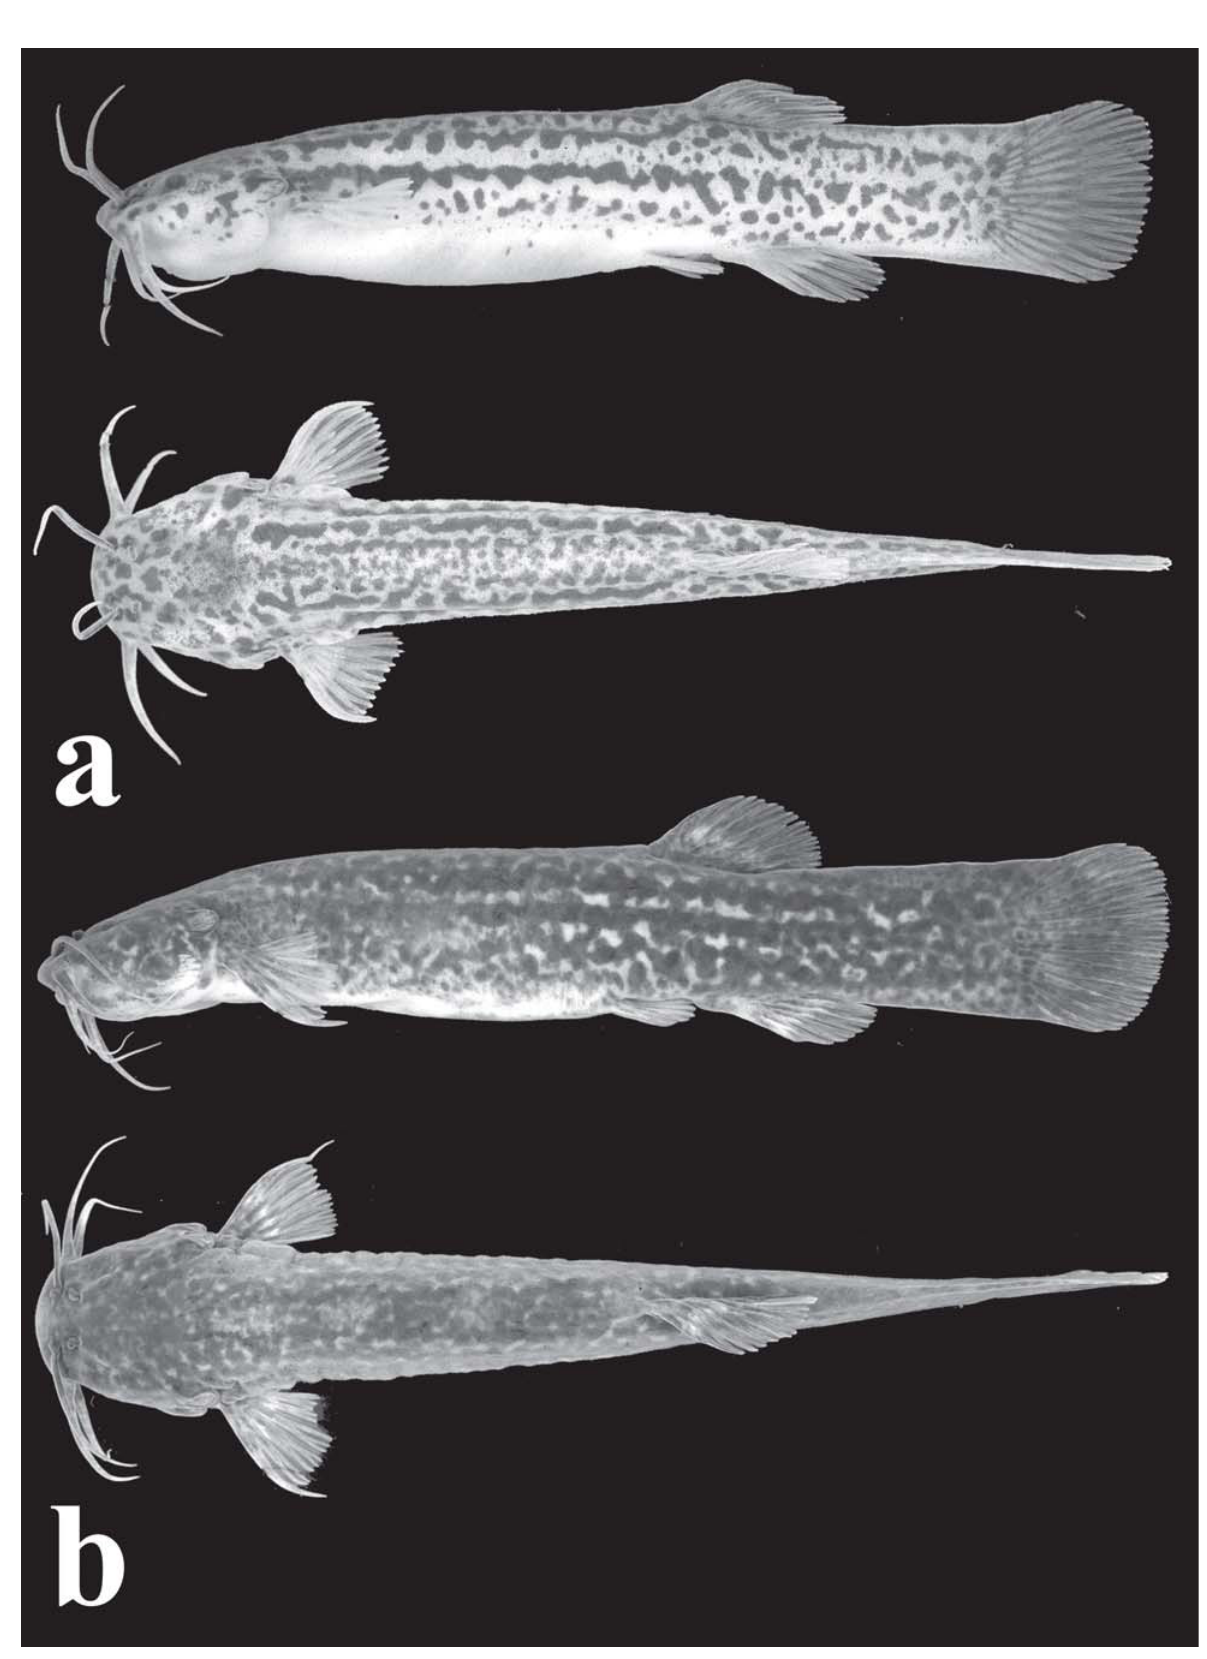
Fig. 11. Trichomycterus sp. of the T. brasiliensis species-complex (LIRP 818), Brazil: São Paulo: município de Cássia dos Coqueiros, ribeirão da Boiada, rio Pardo basin (21º17’40”S 47º08’49”W). a , juvenile, 32.8 mm SL; b , presumed adult, 60.4 mm